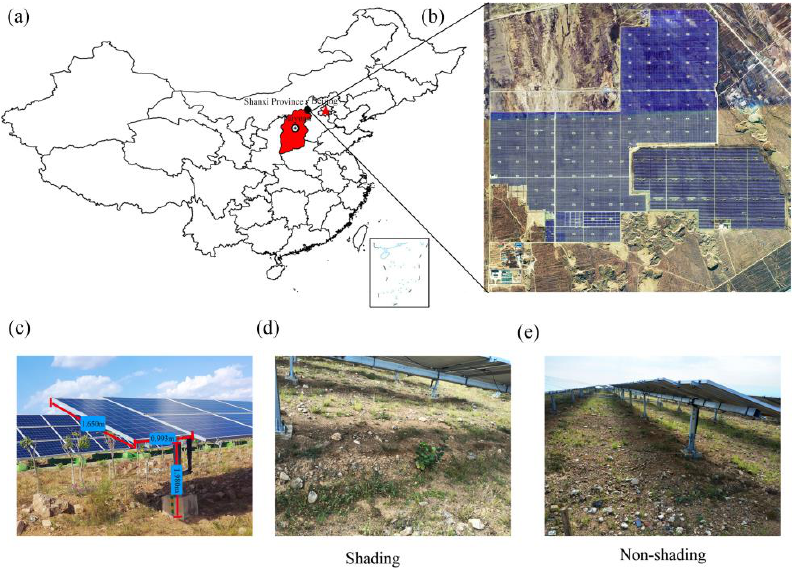
Figure 1. Satellite photograph of the solar station and sampling location of the study area ( a , b ). The erecting height, length, and width of each PV ( c ); the shading and no shading and area under PV ( d , e